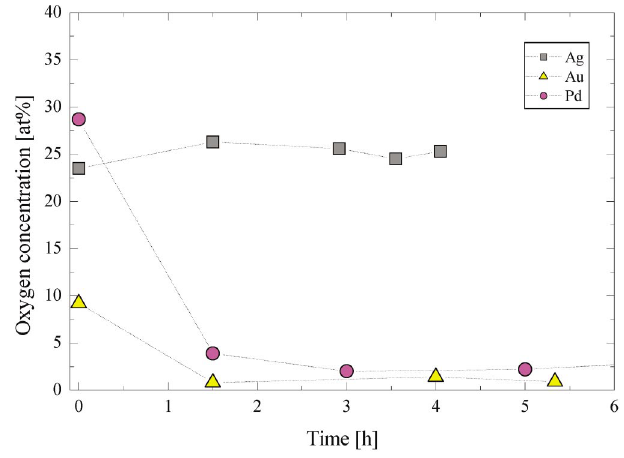
FIG. 7. (Color) Carbon surface concentration of Ag, Au, and Pd coated stainless steel during a 300 (cid:7) C bakeout in UHV.